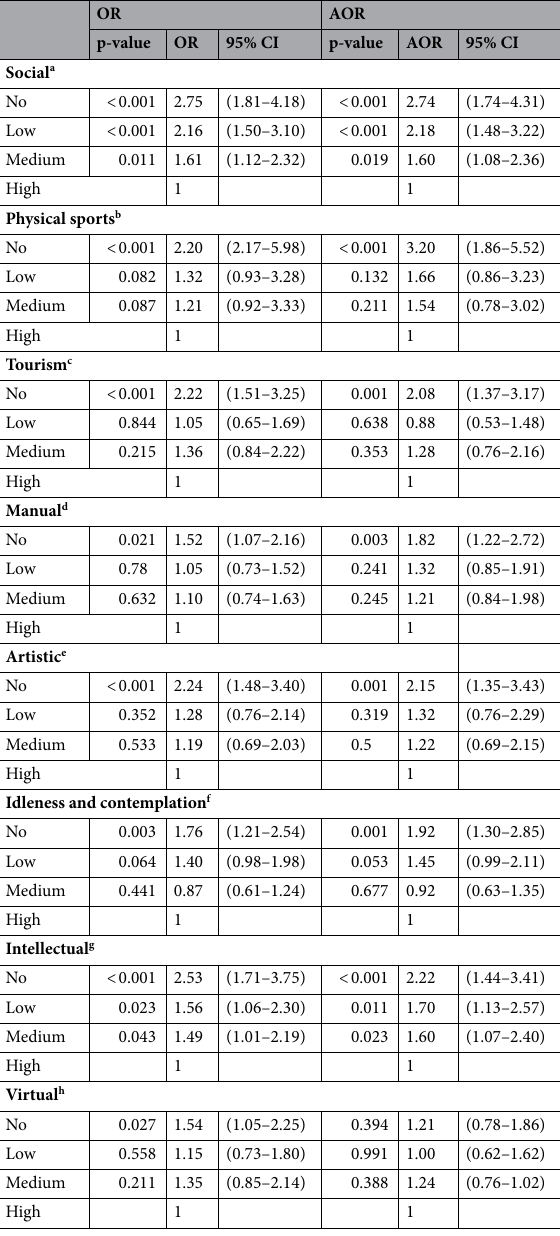
Table 4. Odds ratio and 95% confidence interval for health self-assessment by different leisure involvements. OR odds ratio, AOR adjusted odds ratio, CI confidence interval, AOR model adjusted by Sex, schooling, income, Self-reported illnesses and self-reported intradialytic complications. Hosmer e Lemeshow test: a 0.734; b 0.305; c 0.857; d 0.968; e 0.733; f 0.882; g 0.723; h